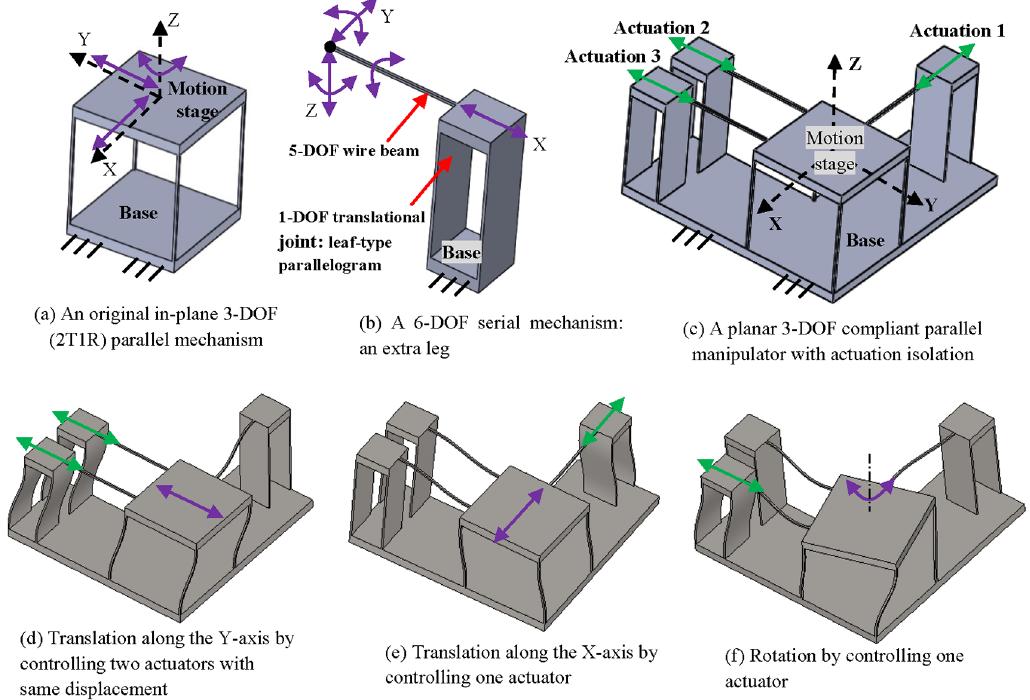
Figure 1. Design of an in-plane 3-DOF 2R1T CPM with actuation isolation.